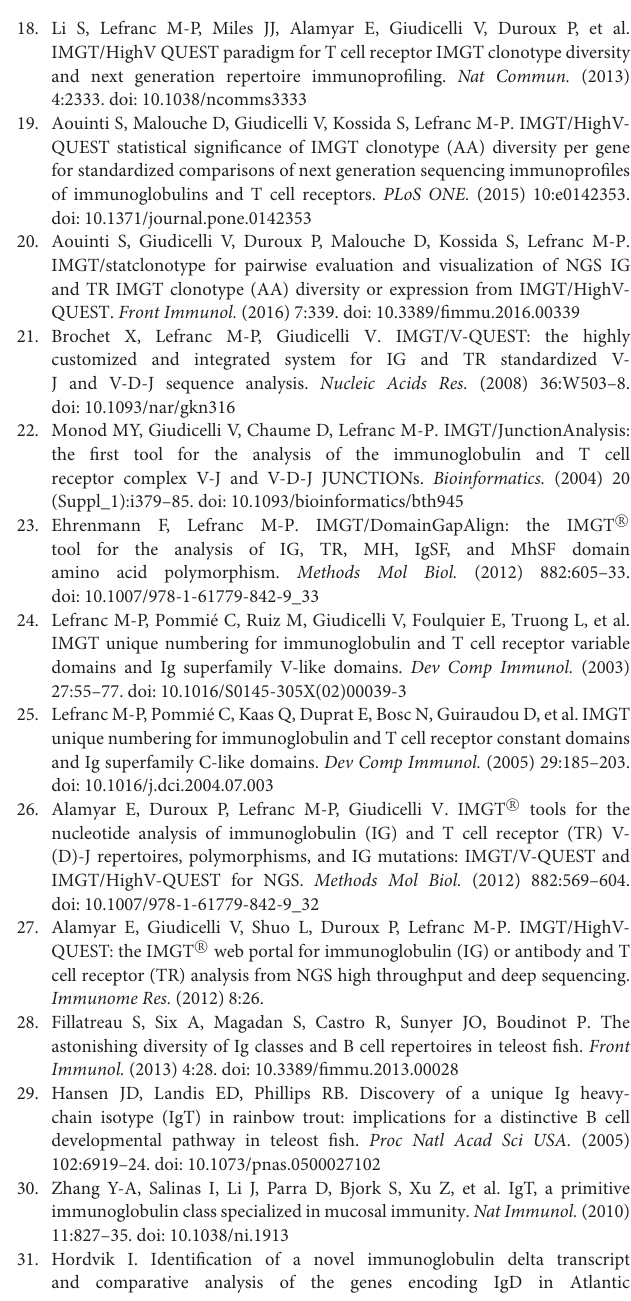
Figure S1 | Alignment of the D-GENE-UNIT sequences of the IGHD (diversity) genes located upstream of the IGHM (locus A) and IGHMD (locus B) genes of Salmo salar (Salsal) and Oncorhynchus mykiss (Oncmyk) (A) and located upstream of IGHT genes (B) . Genes of the locus B genes are identified by the letter D which follows the gene number. Labels are according to the D-GENE